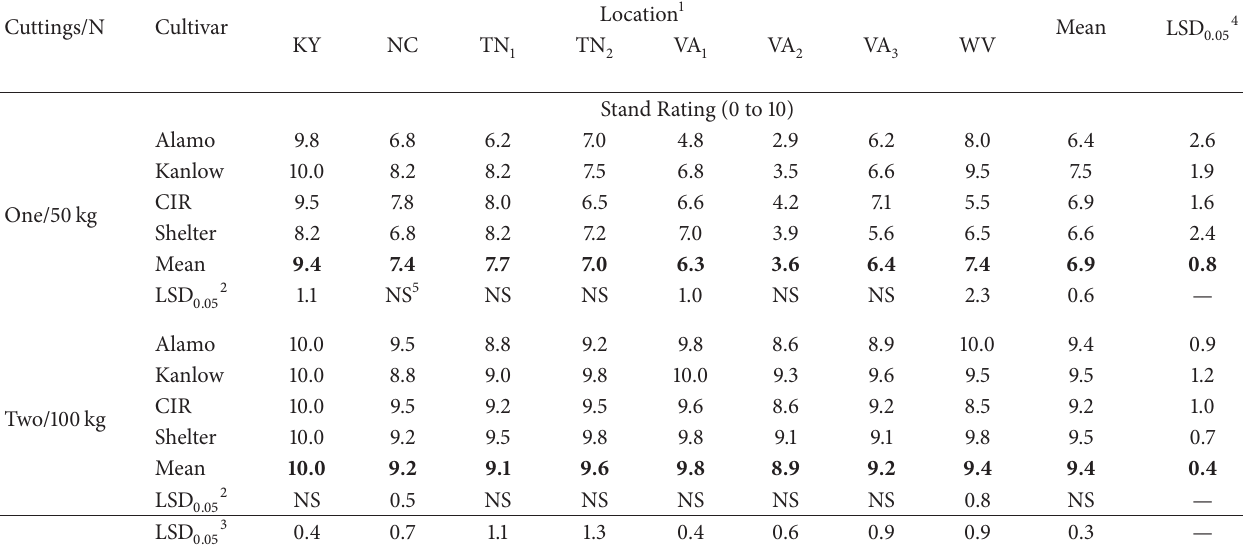
1 Locations: KY (Princeton), NC (Raleigh), TN 1 (Jackson), TN 2 (Knoxville), VA 1,2 (Blacksburg), VA 3 (Orange), and WV (Morgantown). 2 LSD for comparison of managements within a location and ecotype. 3 LSD for comparison of locations within an ecotype and management. 4 LSD for comparison of ecotype means within a location. 5 NS: not significant. Table 9: Stand density ratings (0: least dense, 10: most dense) in November 2001 of four switchgrass cultivars grown under two managements at eight locations in upper southeast USA. Plots had been harvested once (in November) and provided 50 kg N/ha/yr or harvested twice (midsummer and November) and provided 100 kg N/ha/yr for 10 years (CIR: Cave-in-Rock). Cuttings/N Cultivar